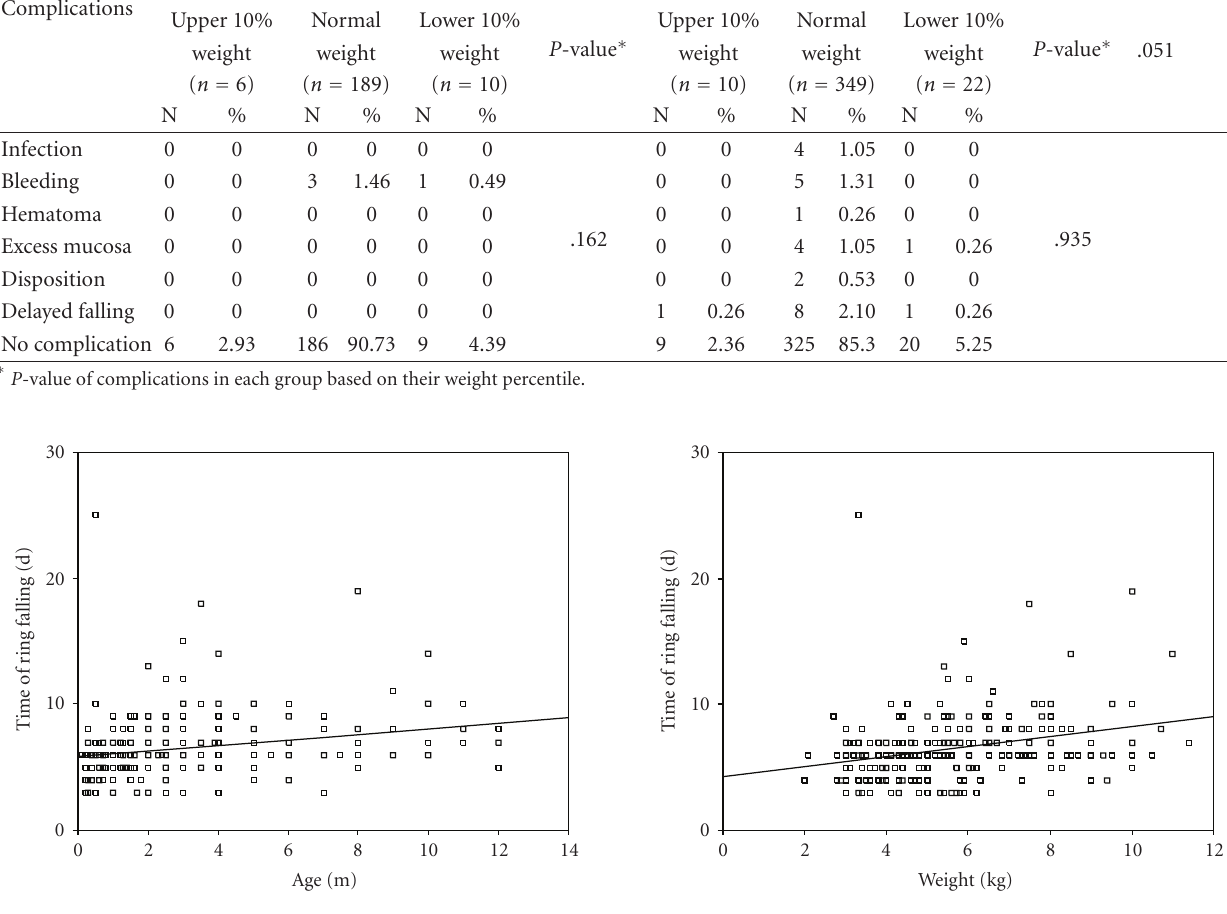
Figure 2: Correlation between the weight of subjects and the bell separation time (Pearson correlation = 0.29, P < .